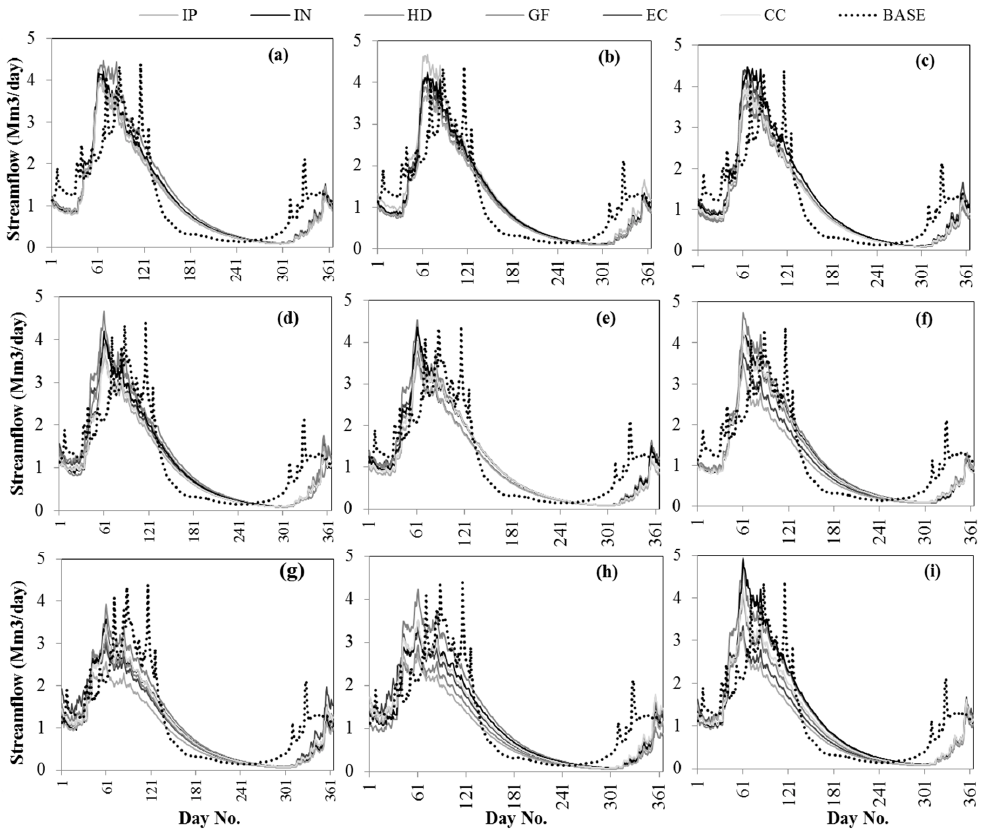
Figure 5. The annual pattern of observed streamflow (dotted graph) and future projected streamflows of SUB-1. ( a ): A1B-2020s; ( b ): A2-2020s; ( c ): B1-2020s; ( d ): A1B-2050s; ( e ): A2-2050s; ( f ): B1-2050s; ( g ): A1B-2080s; ( h ): A2-2080s; ( i ): B1-2080s.